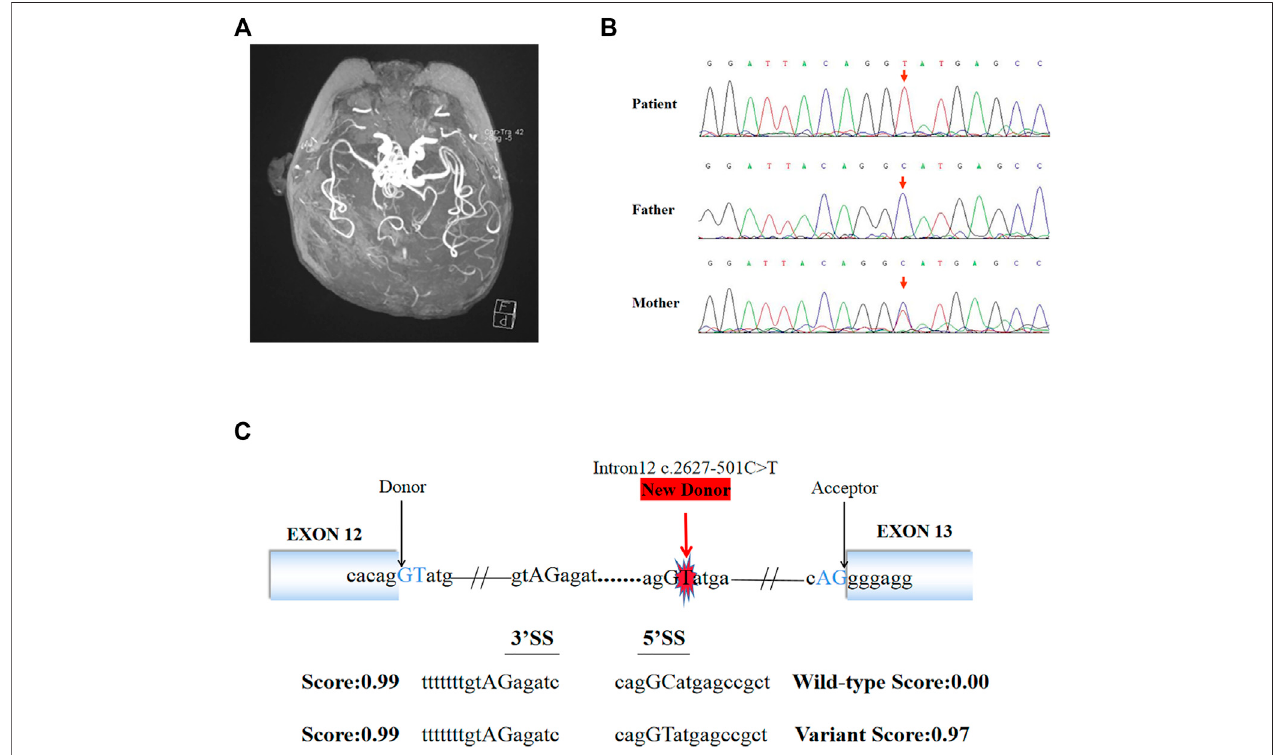
FIGURE 1 | Brain MRI, Sanger sequencing results and splice site prediction schematic of patient. (A) Magnetic resonance angiogram showed the intracranial arteries were tortuous with some “ spiral ” changes. (B) Sanger sequencing con fi rmed that the variant (c.2627-501C > T) of ATP7A gene was inherited from the patient ’ s mother. (C) The prediction results in silico showed the existence of a new 5 ′ donor splice site and a cryptic 3 ′ receptor splice sites. The boxes represented exons, the black arrows pointed to the normal classic splice site, and the red arrow pointed to the new donor splice site caused by the